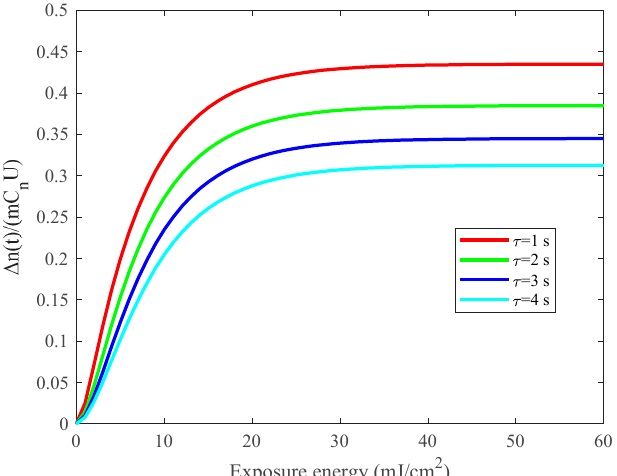
Figure 3. Analysis of factors affecting refractive index modulation: diffusion time constant.